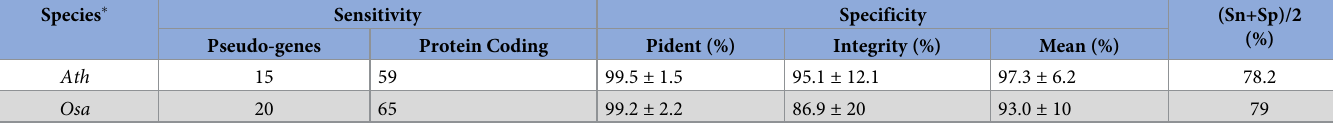
Table 2. The sensitivity and specificity of CTT in finding plant F-box gene members. Species